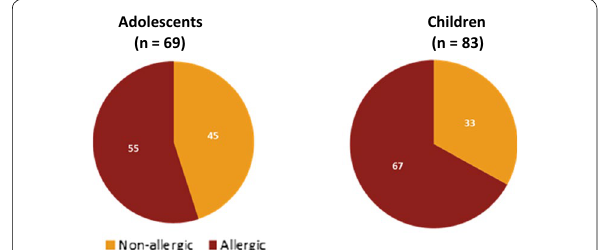
Fig. 1 Proportion (%) of adolescents and children diagnosed with allergic or non-allergic asthma assessed as per individual patient’s